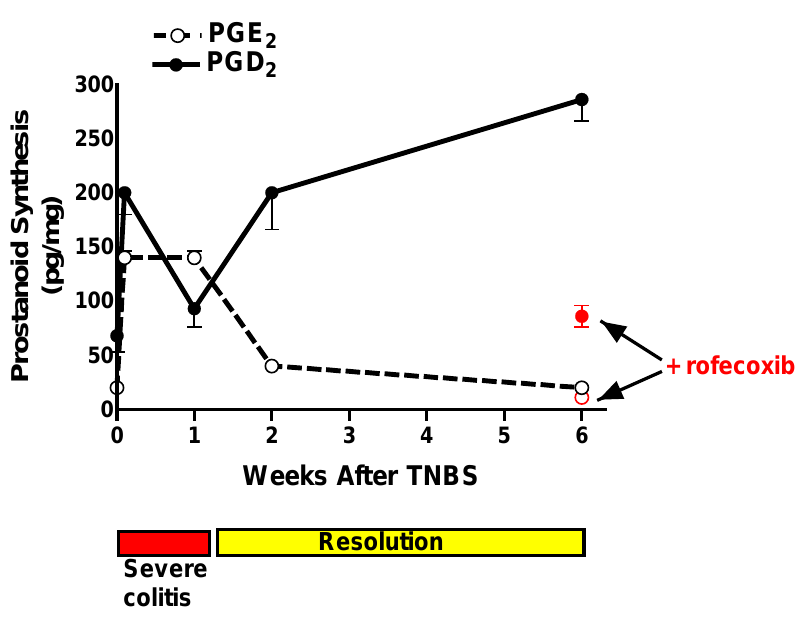
FIGURE 5 . Colonic prostaglandin E 2 and D 2 synthesis during experimental colitis and during the period of resolution of the colitis. Note that PGE 2 synthesis returns to basal levels by 2 weeks after administration of TNBS, the agent that induces the colonic inflammation. However, PGD 2 remains markedly elevated at 6 weeks post-TNBS, when the inflammation has resolved. The PGD 2 synthesis can be inhibited by rofecoxib, indicating that it is derived from COX-2. Further details of these experiments can be found in Zamuner et